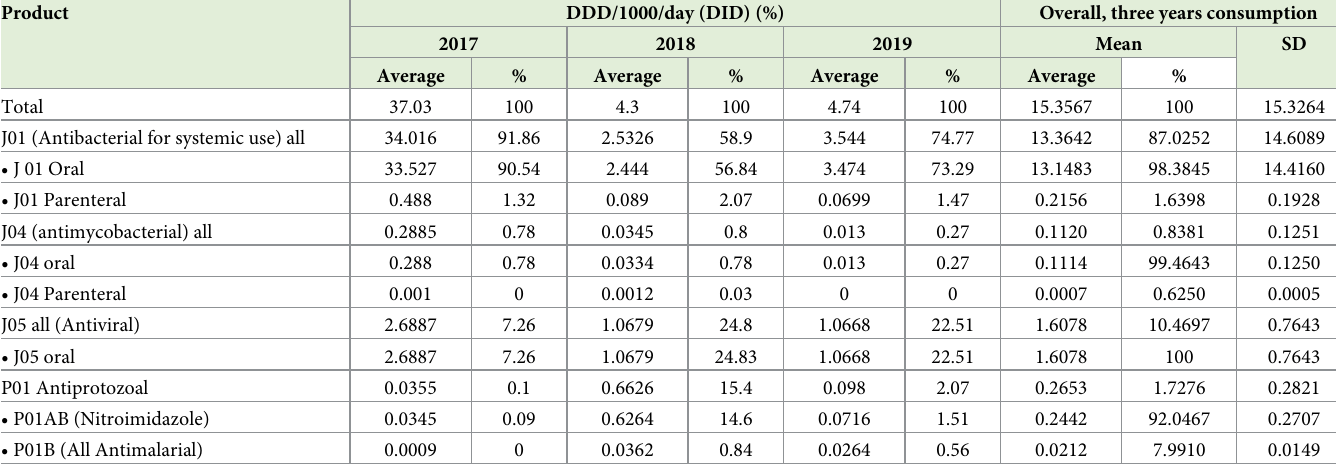
Table 3. Total antimicrobial consumption per defined daily dose (DDD) per 1000 inhabitants per day according to the anatomical, therapeutic, and chemical (ATC) classification system and by route of administration.